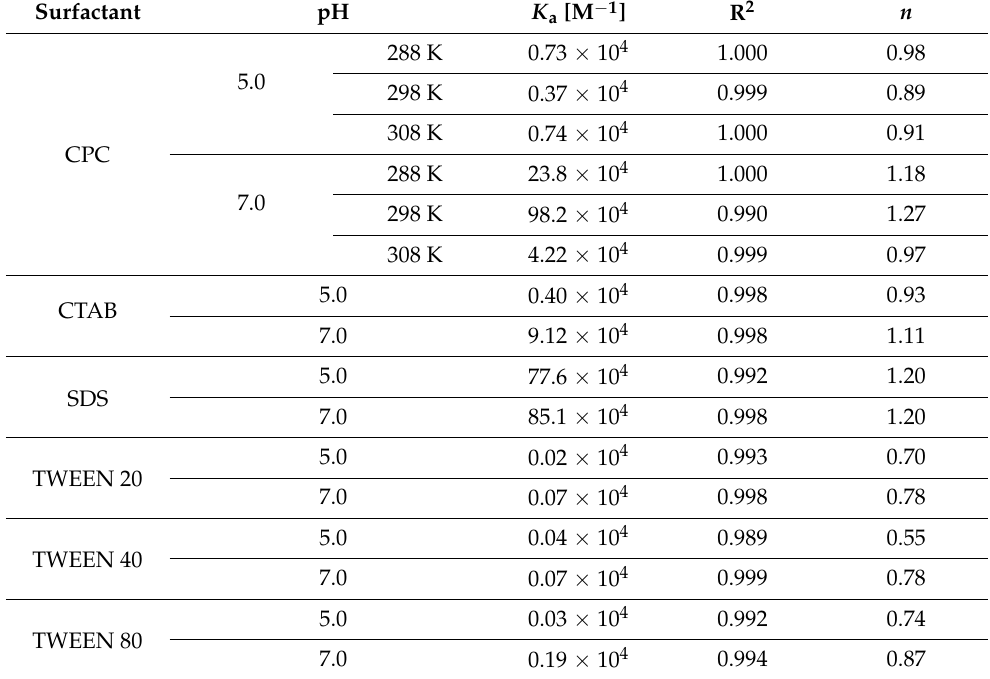
Table 2. Apparent binding constants ( K a ), linear correlation coefficients (R 2 ) and numbers of binding sites ( n ) recovered for the steady-state fluorescence quenching of BSA by various surfactants in 10 mM CACO buffer of pH 5.0 and 7.0 at 298 K (for CPC additionally at 288 and 308 K). Surfactant pH K a [M − 1